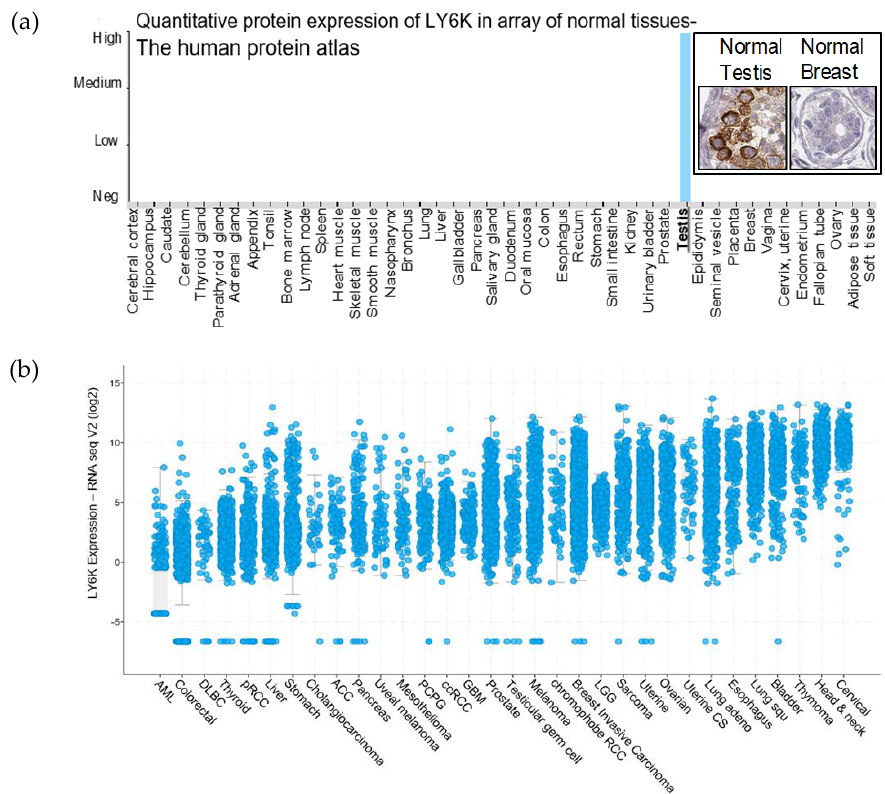
Figure 1. Lymphocyte antigen 6K (LY6K) is an ideal target for cancer therapeutics. ( a ) The Human Protein Atlas data shows quantification of Immunohistochemistry (IHC) using a nuclear magnetic resonance (NMR) validated, affinity purified using the PrEST-antigen as affinity ligand HPA017770 (Sigma) antibody for LY6K, in a panel of human normal tissues. The intensity of IHC labeling is shown on the Y-axis, and the X-axis shows the names of organs tested. In the inset, IHC images are shown from normal testis and breast using LY6K antibody. ( b ) cBioPortal data visualization using TCGA 2018 release data suggest high expression of LY6K in multiple cancer types.